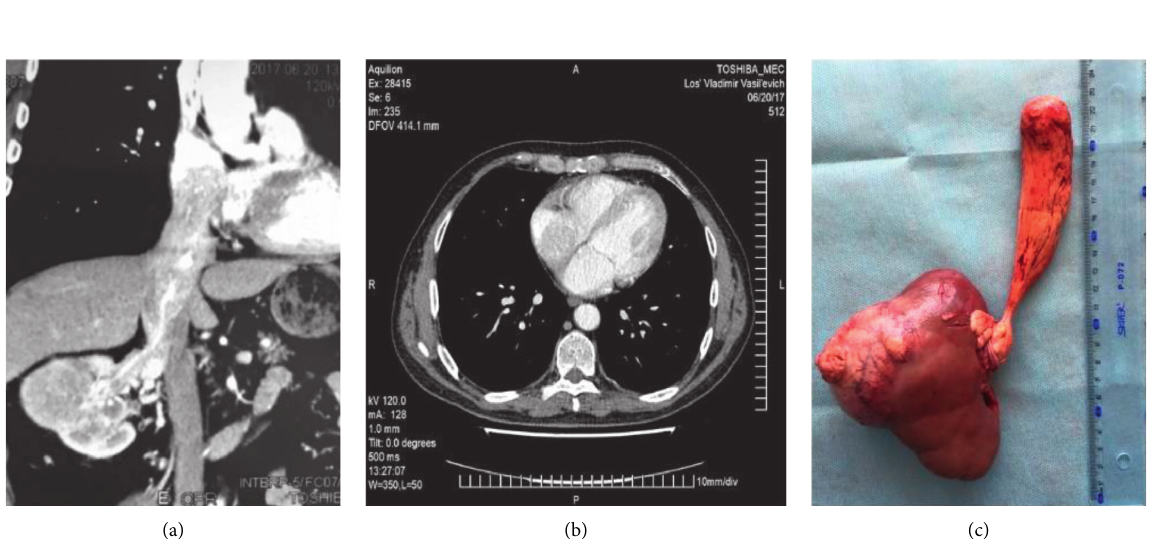
Figure 1: MDCT ((a) frontal reconstruction and (b) axial scan) and surgical specimen (c) of a patient with cavoatrial extension of RCC. The length of the atrial part of the tumor thrombus is 3.5cm.